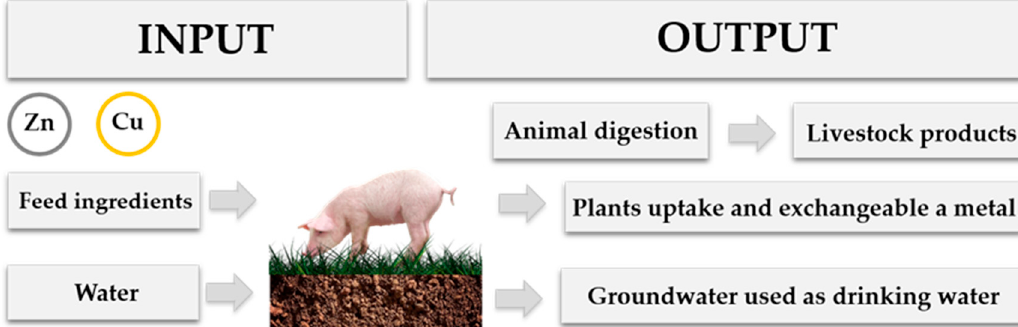
Figure 1. Possible routes of HMs entrance to the food chain and the consequences of their output.